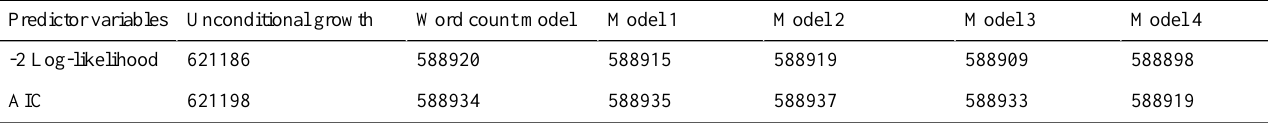
Table 2. Mixed models, model fit